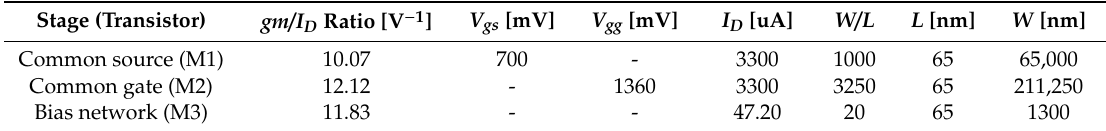
Table 4. LNA MOS physical design parameters result for maximum gain.